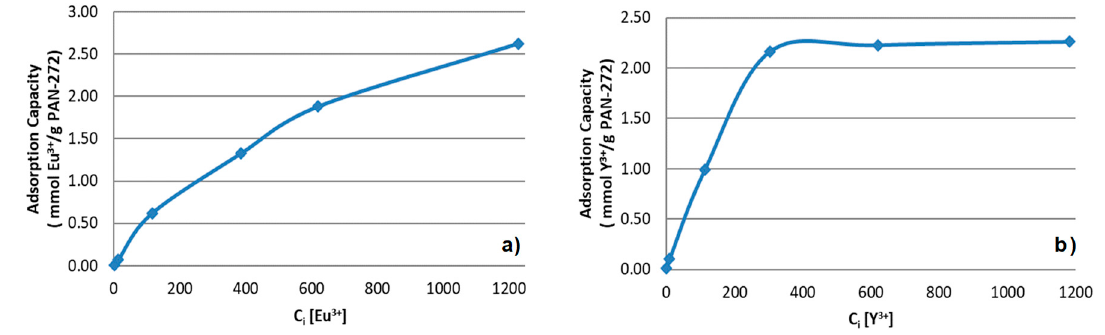
Figure 7. Effect of initial concentration of ( a ) Eu(III) and ( b ) Y(III) in the adsorption process using PAN-272.